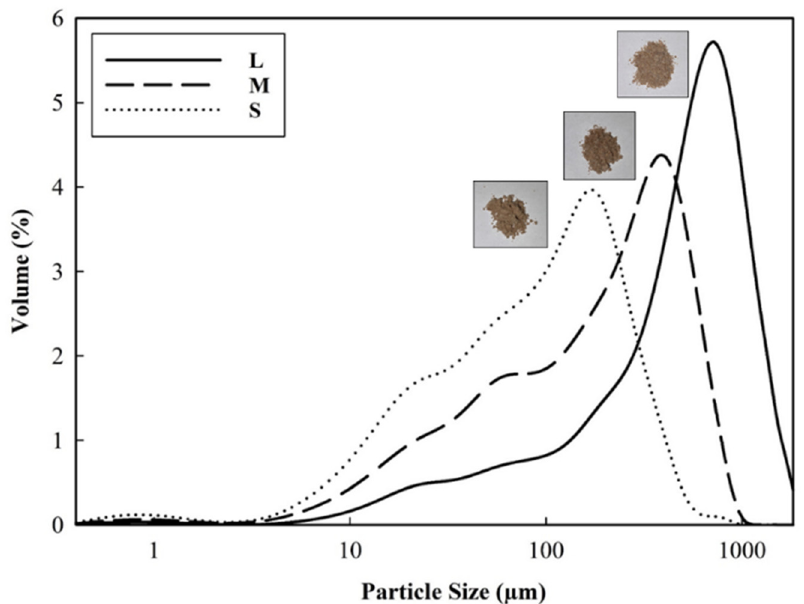
Figure 1. The particle size distribution of wheat bran with size reduction determined by laser diffraction. L, M, and S indicate the brans with large, medium, and small particle sizes.